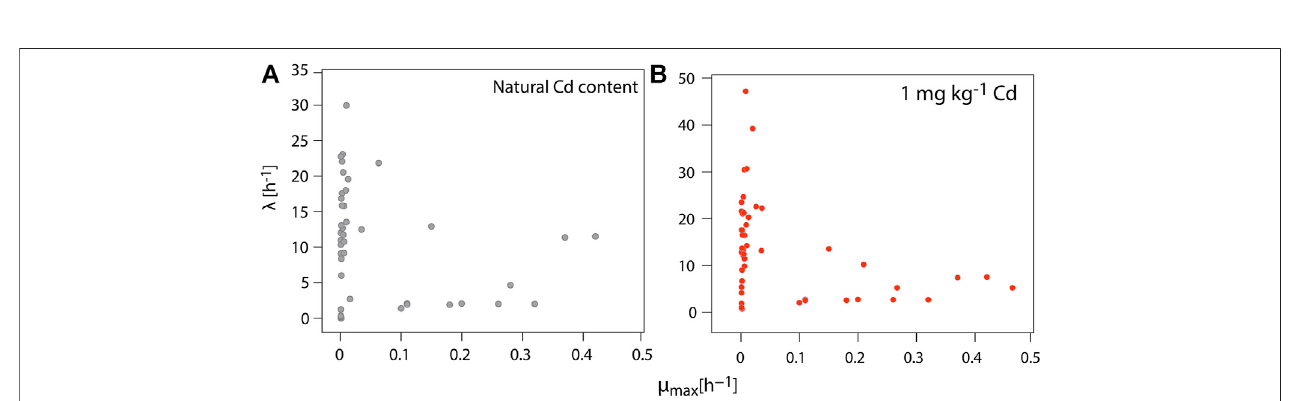
FIGURE 4 | A Pearson correlation between the maximum growth rate and the adaptation phase of the CdtB populations into the composite soil samples, when exposed to (A) natural Cd content and (B) an amendment with 1 mg kg − 1 of CdCl 2 . The kinetic growth parameters were calculated after fi tting the edited data with the Gompertz equation ( p ≤